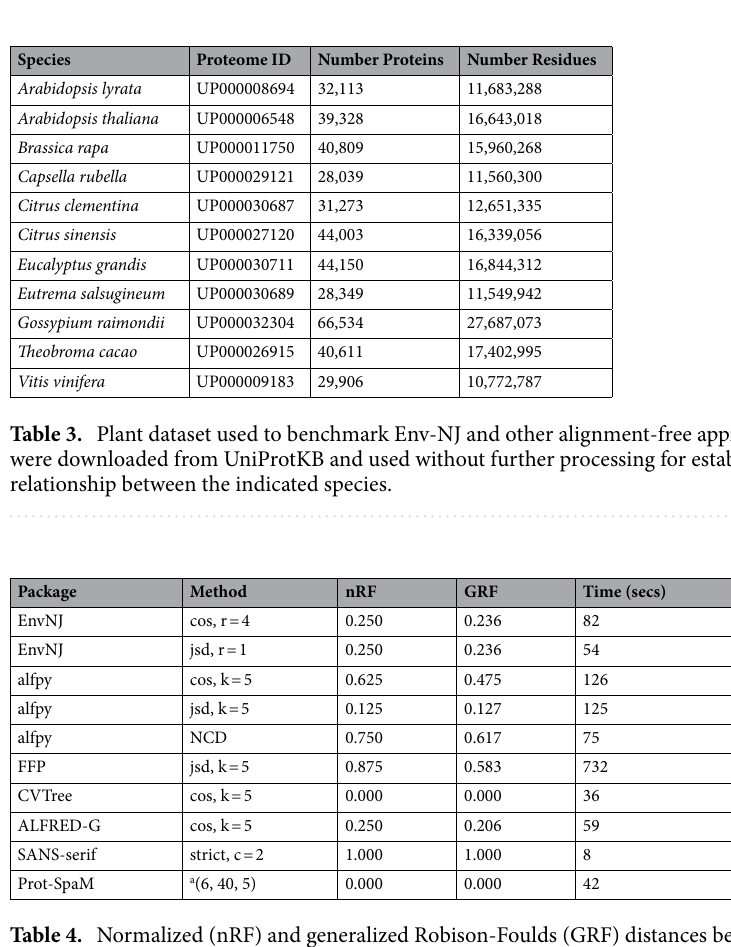
Table 4. Normalized (nRF) and generalized Robison-Foulds (GRF) distances between trees obtained using different alignment-independent methods with respect to the reference tree for the 11 plant species indicated in Table 3, which was obtained from AFproject 25 . For details regarding the input parameters used for each method, please consult the given reference. Briefly, cos and jsd stand for cosine and Jensen-Shannon metrics, respectively. (a) The parameters for the use of Prot-SpaM were weight of w = 6, with d = 40 (don’t-care positions) and m = 5 patterns. The parameter filter of SANS-serif was set to ‘strict’. NCD is the acronym of normalized compression distance. Runtimes were obtained with an Intel(R) Core(TM) i5-8600 CPU 3.10